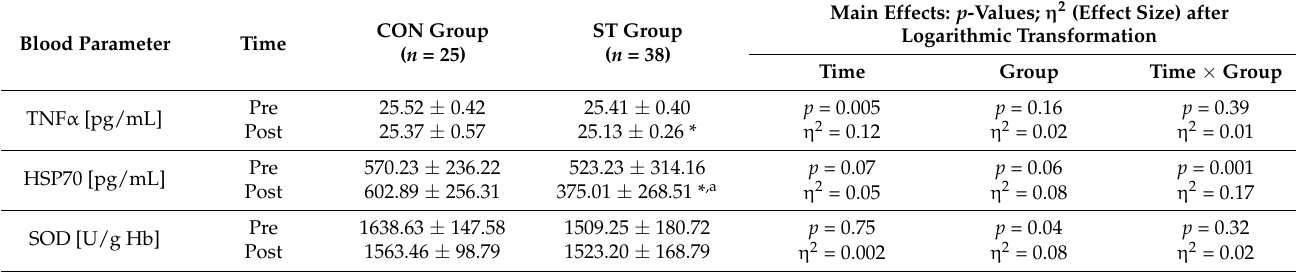
Table 2. Biochemical parameters in blood prior to (pre) and after (post) 12-week in the study group (control, CON; swimming training,